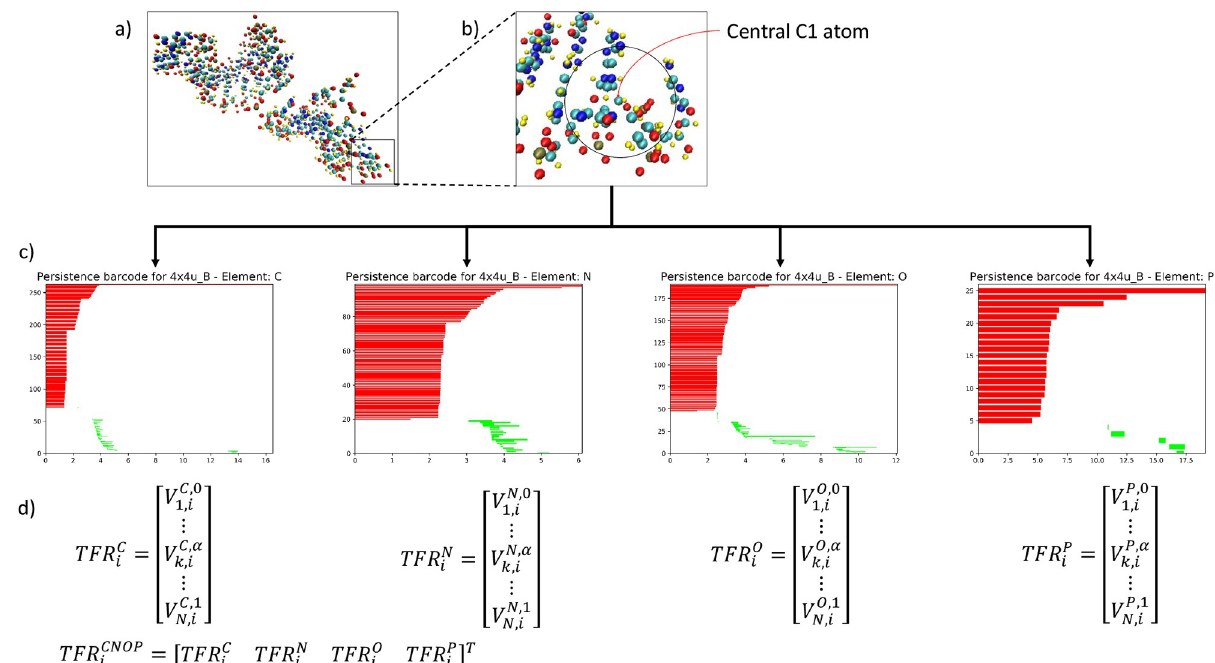
Fig 1. (a) Chain B of RNA 4X4U with each element (C, N, O, P and H) highlighted in a different colour. (b) In order to apply LPH, a local region and all the atoms within the local region for each central C1 atom is determined. However, only the elements of C, N, O and P are considered. (H highlighted in yellow is ignored) (c) Localized ESPH is applied and a persistent barcode is plotted for each of the four elements. (d) Binning approach is applied to each PB and the corresponding topological feature representation (TFR) of a sample i is obtained. The feature vector of four-element is a concatenated vector of all four TFRs. The feature vectors are then used for ML